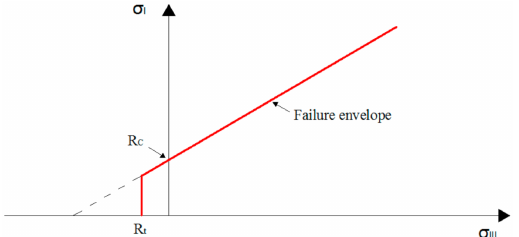
Figure 2. Failure envelope in the principal stress plane [19].